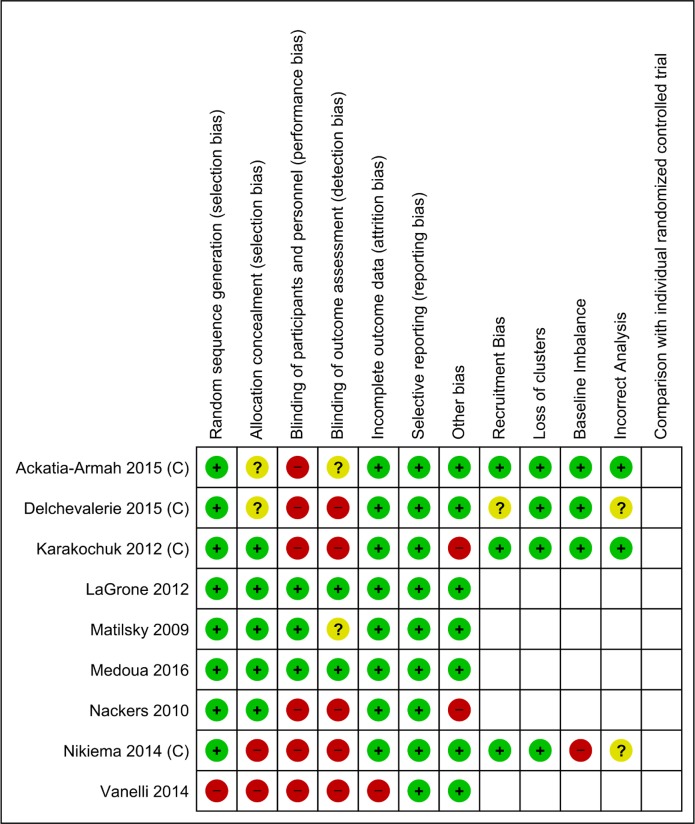
Risk of bias summary.Review authors' judgements about each risk of bias item for each included study.